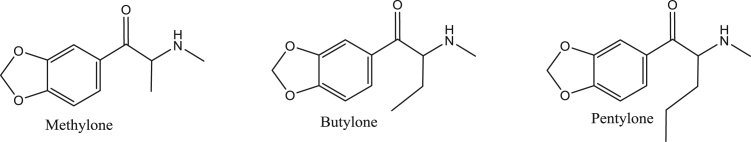
Chemical structures of the synthetic cathinones examined in this study. These synthetic cathinones differ by lengthening of the α-alkyl chain: methylone (-CH3), butylone (-CH2CH3), and pentylone (-CH2CH2CH3).